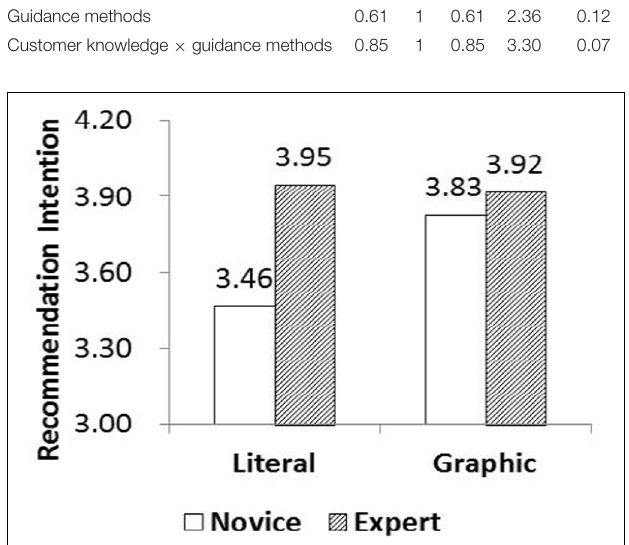
FIGURE 3 | Interaction between customer knowledge and guidance